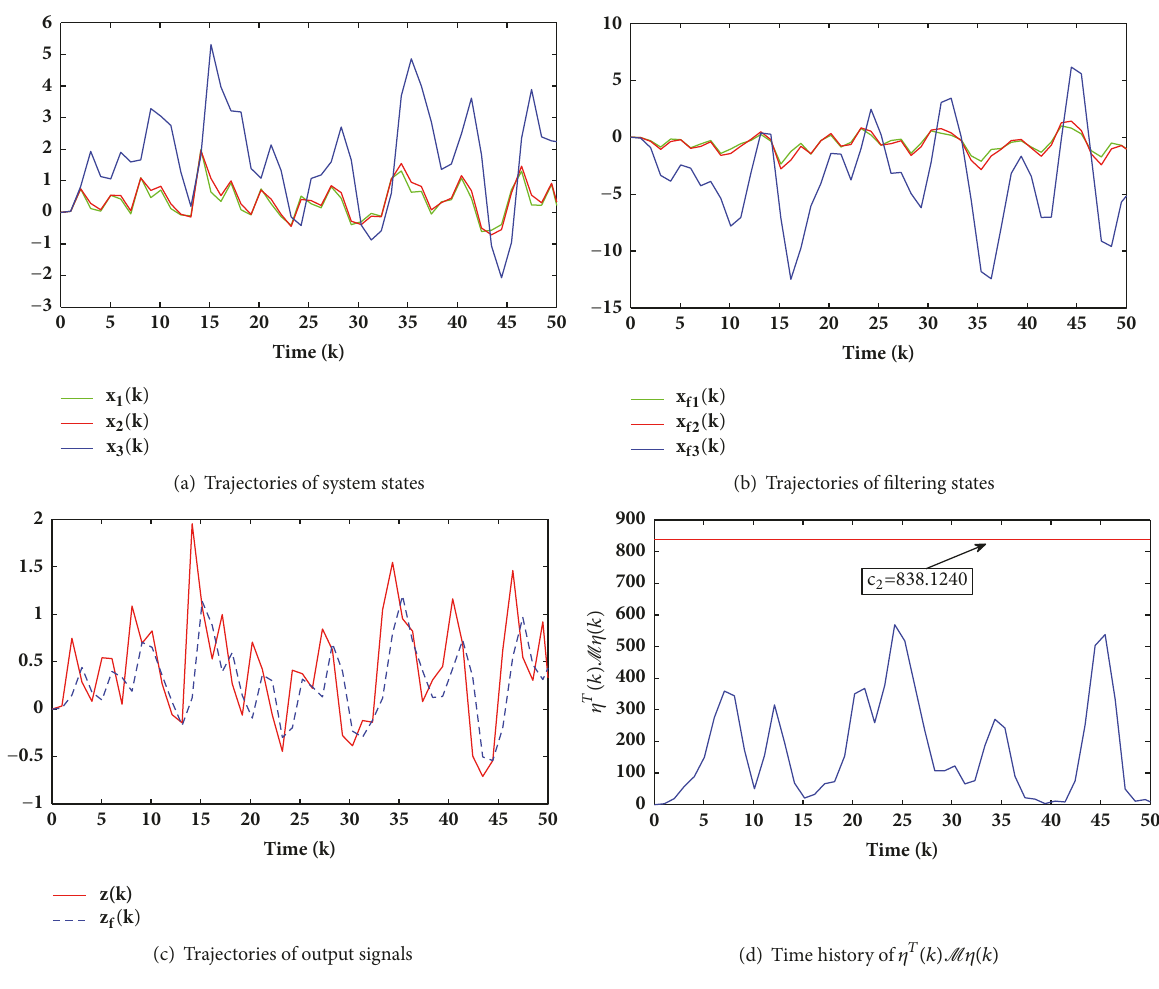
Figure 2: Simulation results of Example